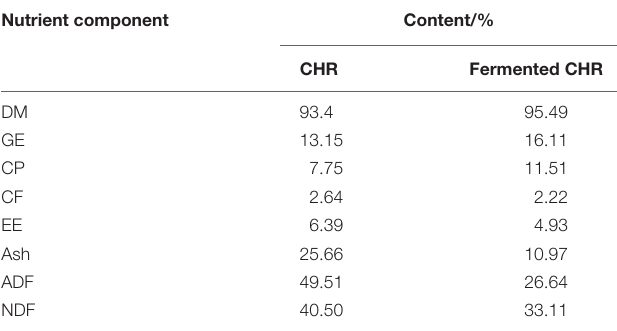
TABLE 1 | Nutrient levels of CHR and fermented CHR.